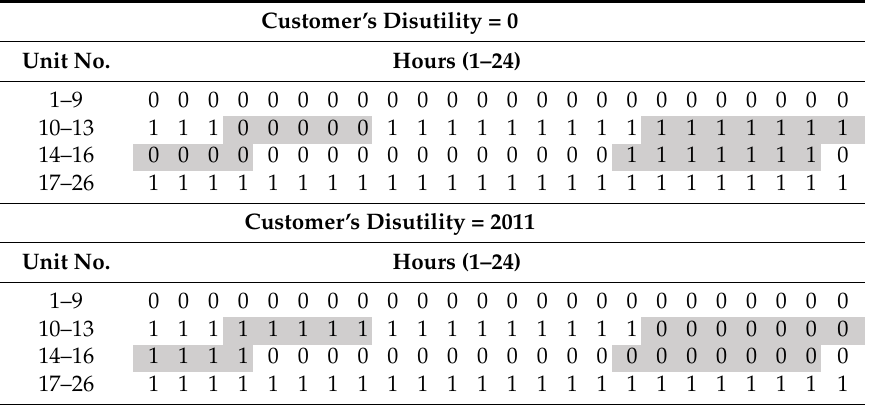
Table 1. Unit commitment status for two customer disutility levels.